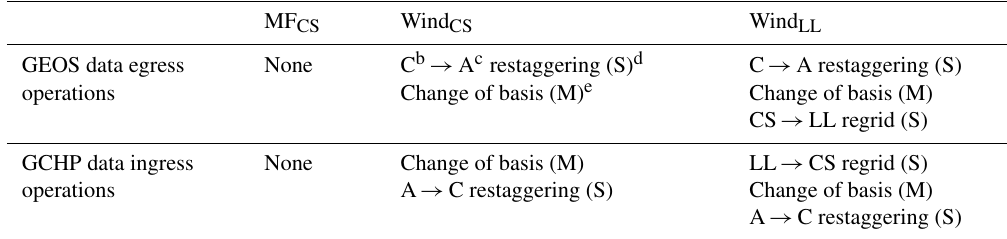
Table 3. Operations applied to GEOS advection data for input to GCHP a